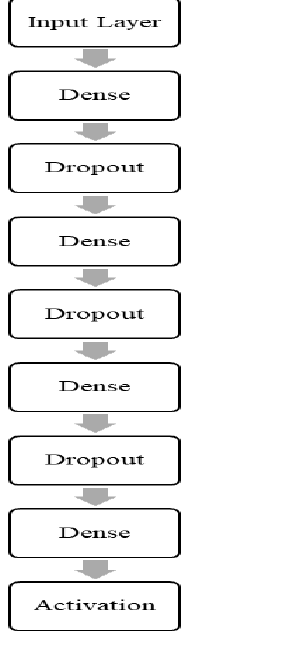
Fig. 2 3-Layer Multi-Layer Perceptron (MLP) Model